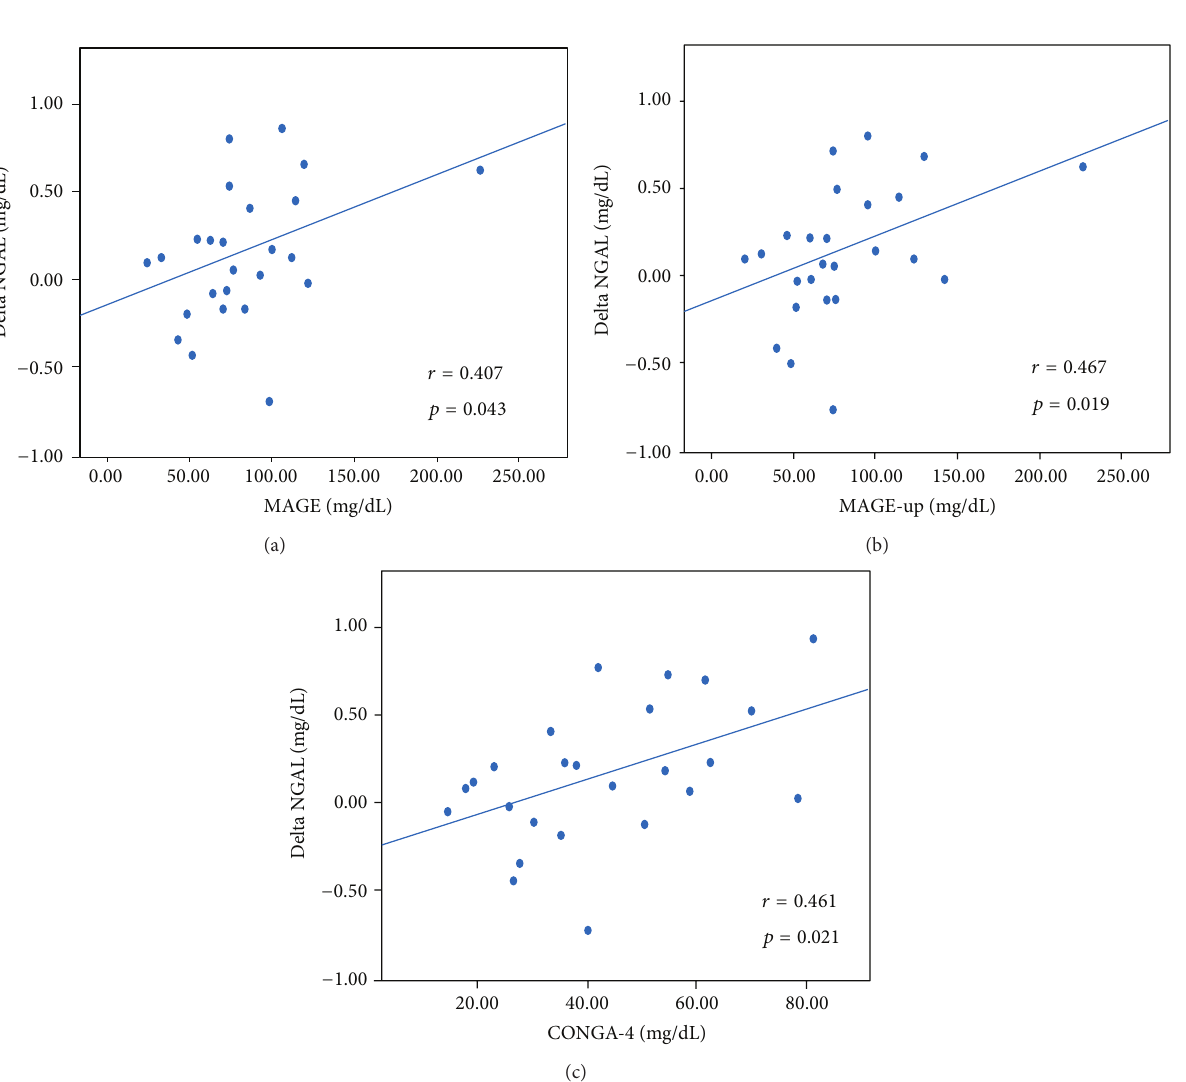
Figure 3: Correlation between periprocedural glycemic variability (expressed as MAGE, MAGE-up, and CONGA-4) and postprocedural NGAL variation. CONGA-4: continuous overall net glycemic action at 4 hours; MAGE: mean amplitude glycemic excursions; MAGE-up: mean amplitude glycemic nadir-to-peak